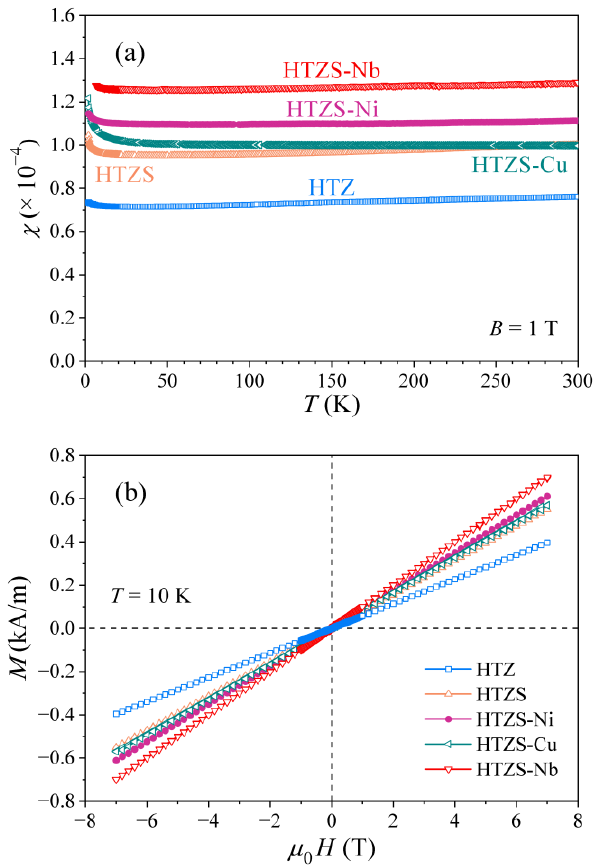
Figure 8. ( a ) Temperature-dependent magnetic susceptibility 𝜒 of the HTZ, HTZS, HTZS-Ni, HTZS-Cu, and HTZS-Nb alloys, measured in a field 𝜇 0 𝐻 = 1 T (the 𝜒(𝑇) curve of the HTZS-Nb is shown only in the normal state down to 5 K). ( b ) The normal-state 𝑀(𝐻) curves at 𝑇 = 10 K. The lowest accessible temperature of 1.8 K in our magnetic experiments has pre- vented us to observe the Meissner effect for the superconducting HTZ, HTZS, and HTZS- Ni samples because their 𝑇 𝐶 s are too low, whereas it could be detected in the HTZS-Nb sample with 𝑇 𝐶 ≈ 4.0 K. The Meissner effect in the HTZS-Nb alloy is demonstrated in